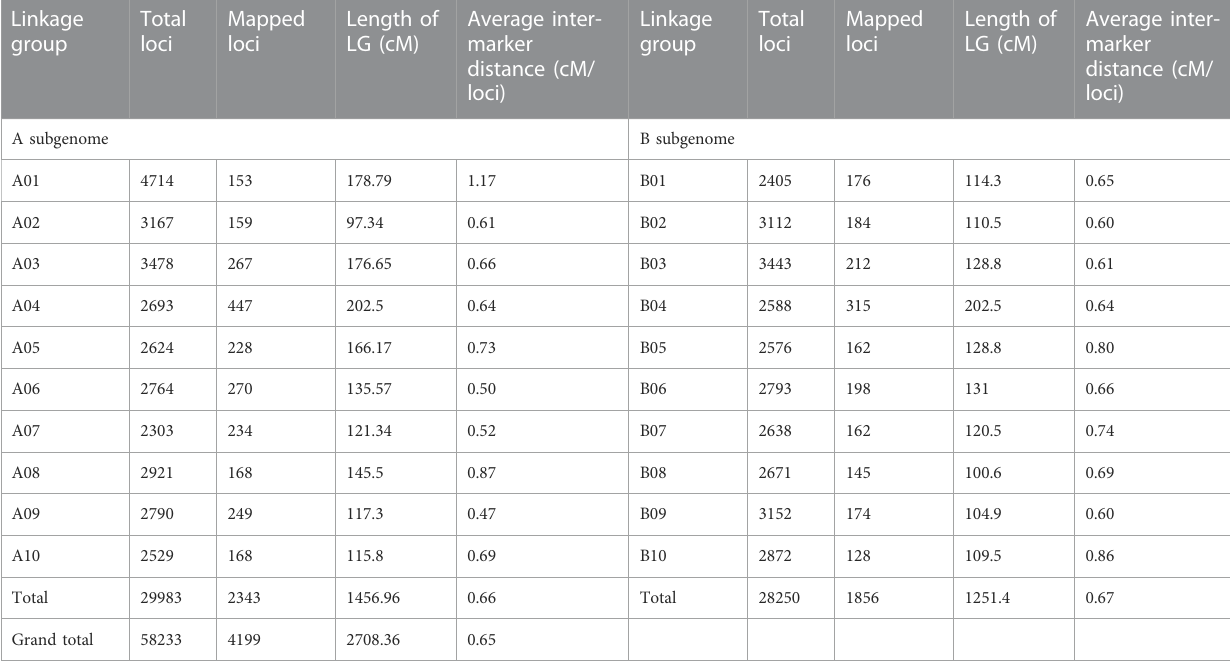
TABLE 1 Summary of a genetic map constructed based on RIL population Chico × ICGV 02251. Linkage